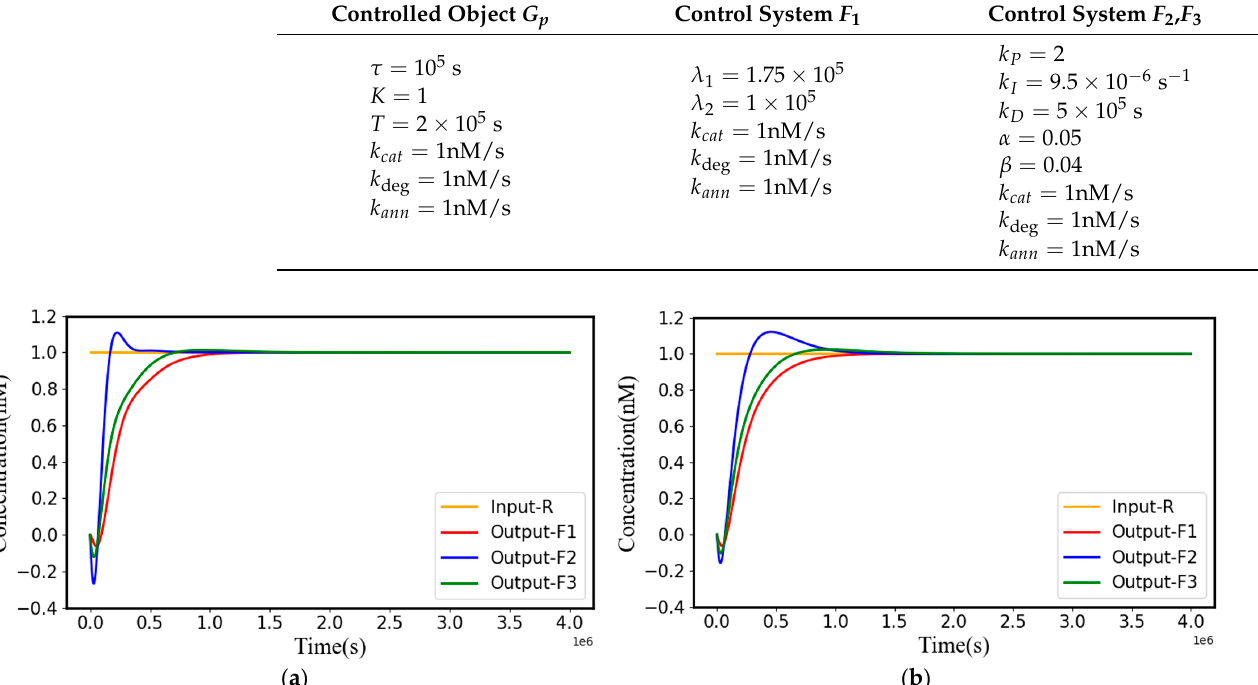
Table 1. Parameters of controlled object G p ( s ) and control systems F i ( i = 1,2,3 ) .